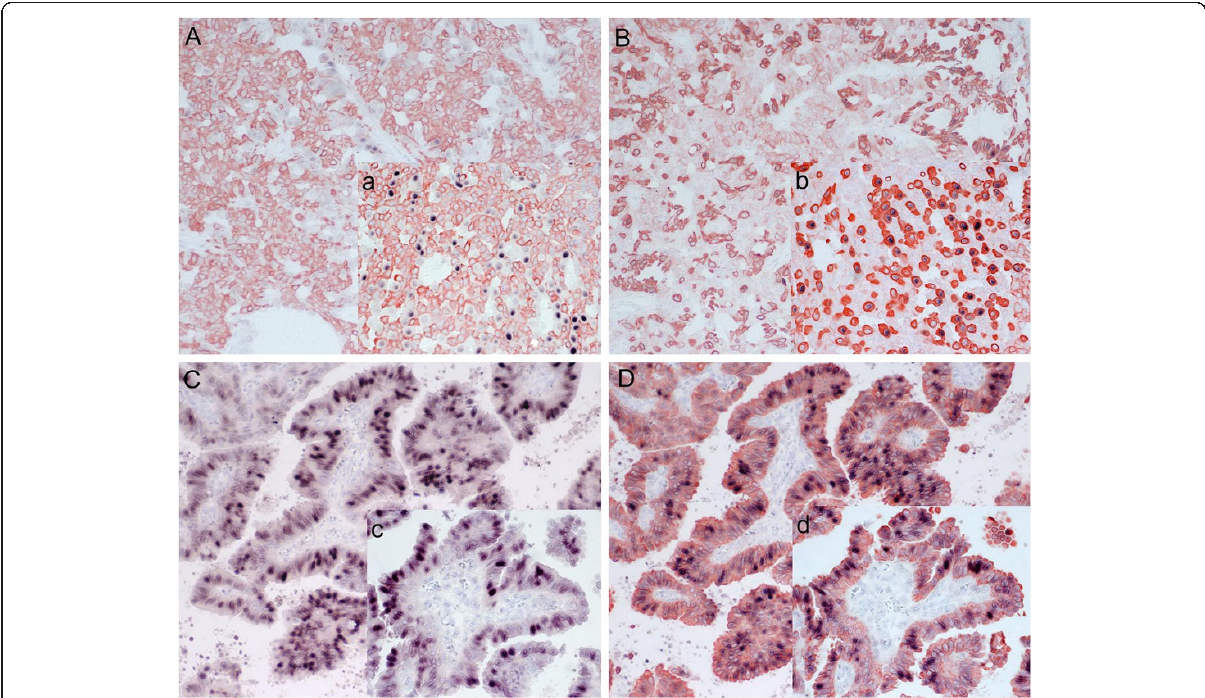
Figure 1 Immunohistochemical double staining for Cyclin D1 and CK 5/6 or CK 8/18 in papilloma (A B, original magnification × 200; a b, original magnification × 400) and in papillary carcinoma (C D, original magnification × 200; c d, original magnification × 400). The cytoplasm of the cells expressing CK 5/6 is stained pale red and CK 8/18 was stained red, whereas the cytoplasm of cells expressing CK 8/18 is stained red. The nuclei of Cyclin D1 positive cells are stained black. ( A , a ) Immunohistochemical double staining for Cyclin D1 and CK 5/6 in a papilloma. The Cyclin D1 positive cells were hardly detected in ( A ). ( B , b ) Immunohistochemical double staining for Cyclin D1 and CK 8/18 in a papilloma. There were a few Cyclin D1 positive cells detected in ( B ). Upon comparing ( a ) and ( b ), Cyclin D1 expression is clear in the cells that are positive for CK 8/18 in contrast to the cells that are positive for CK 5/6 in the papillomas. ( C , c ) Immunohistochemical double staining for Cyclin D1 and CK 5/6 in papillary carcinoma. The cells are not immunoreactive for CK 5/6. ( D , d ) Immunohistochemical double staining for Cyclin D1 and CK 8/18 in papillary carcinomas. Cyclin D1 ( D ) localizes in practically the same position compared with ( C ). The number of the Cyclin D1 positive cells ( C , D ) clearly increases, in contrast to ( A ) and ( B ). As in the papillomas, Cyclin D1 only appears in the cells that co-express CK